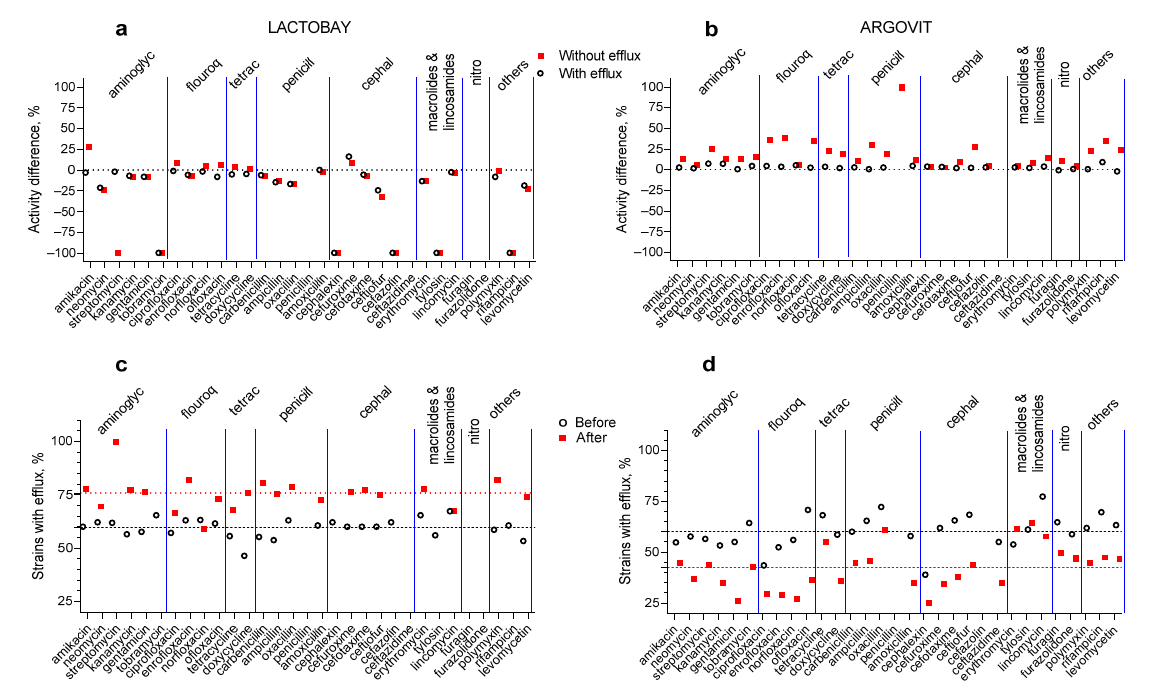
Figure 3. Percentage difference between activity (activity value after treatment minus activity value before treatment) of 31 antibiotics against S. aureus for treatment with Lactobay ( a ) and Argovit-C ( b ): isolates with the efflux effect (white circles) and without the efflux effect (red squares) and contribution of isolates with the efflux effect before (white circles) and after (red squares) treatment with Lactobay ( c ) and Argovit-C ( d ).